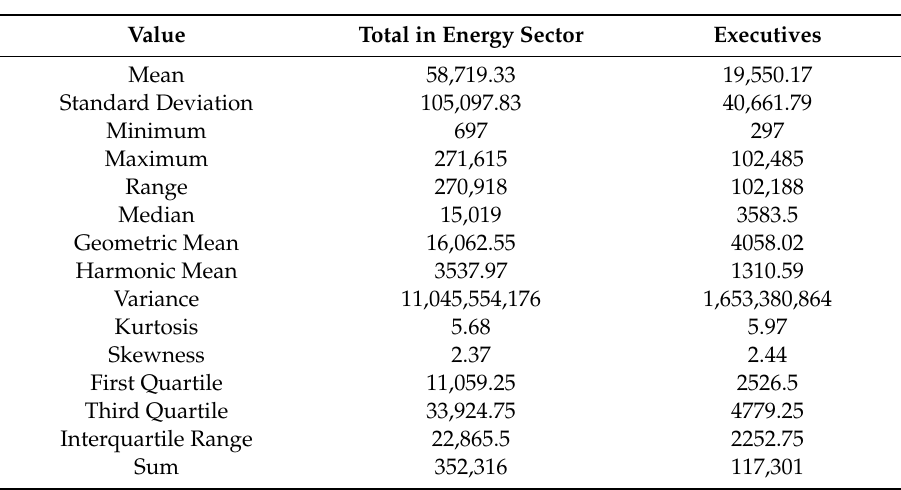
Table A5. Descriptive statistics of the total number of job o ff ers and job o ff ers for executives (see Table 1).